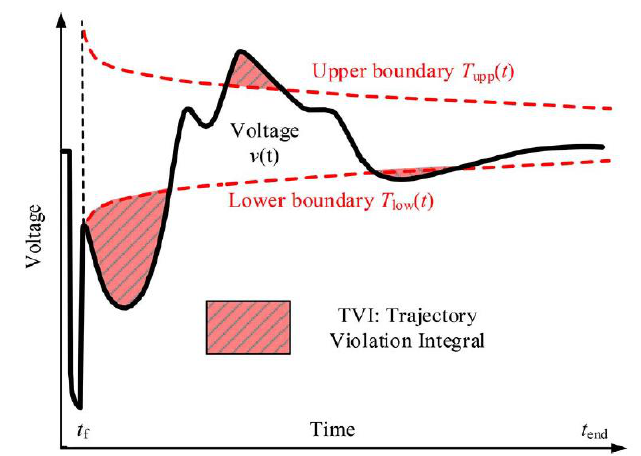
Figure 4. An illustrative example of the TVI concept on a fault-induced voltage drop [22]. Copyright permission from IEEE.